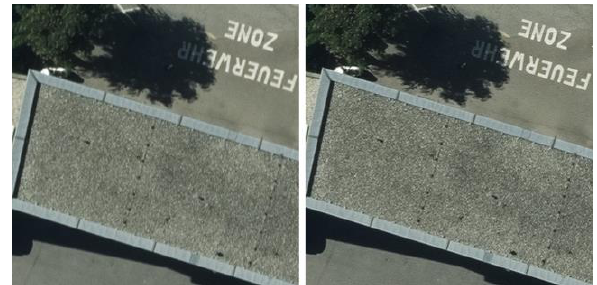
Figure 8 : Some forward motion blur exists (cf. left image) and was successfully compensated by AMC (cf. right image)